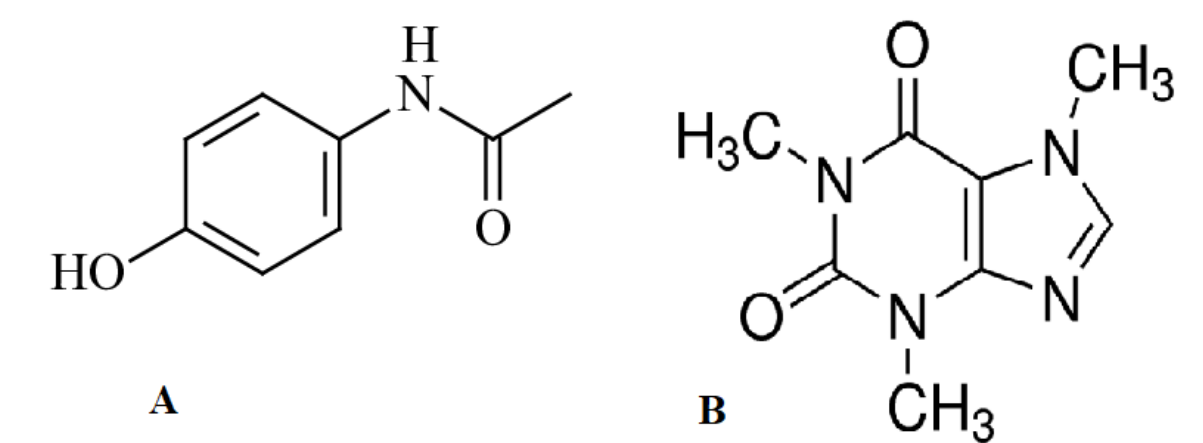
Figure 1. Chemical structures of ( A ) PCM and ( B ) CAF.